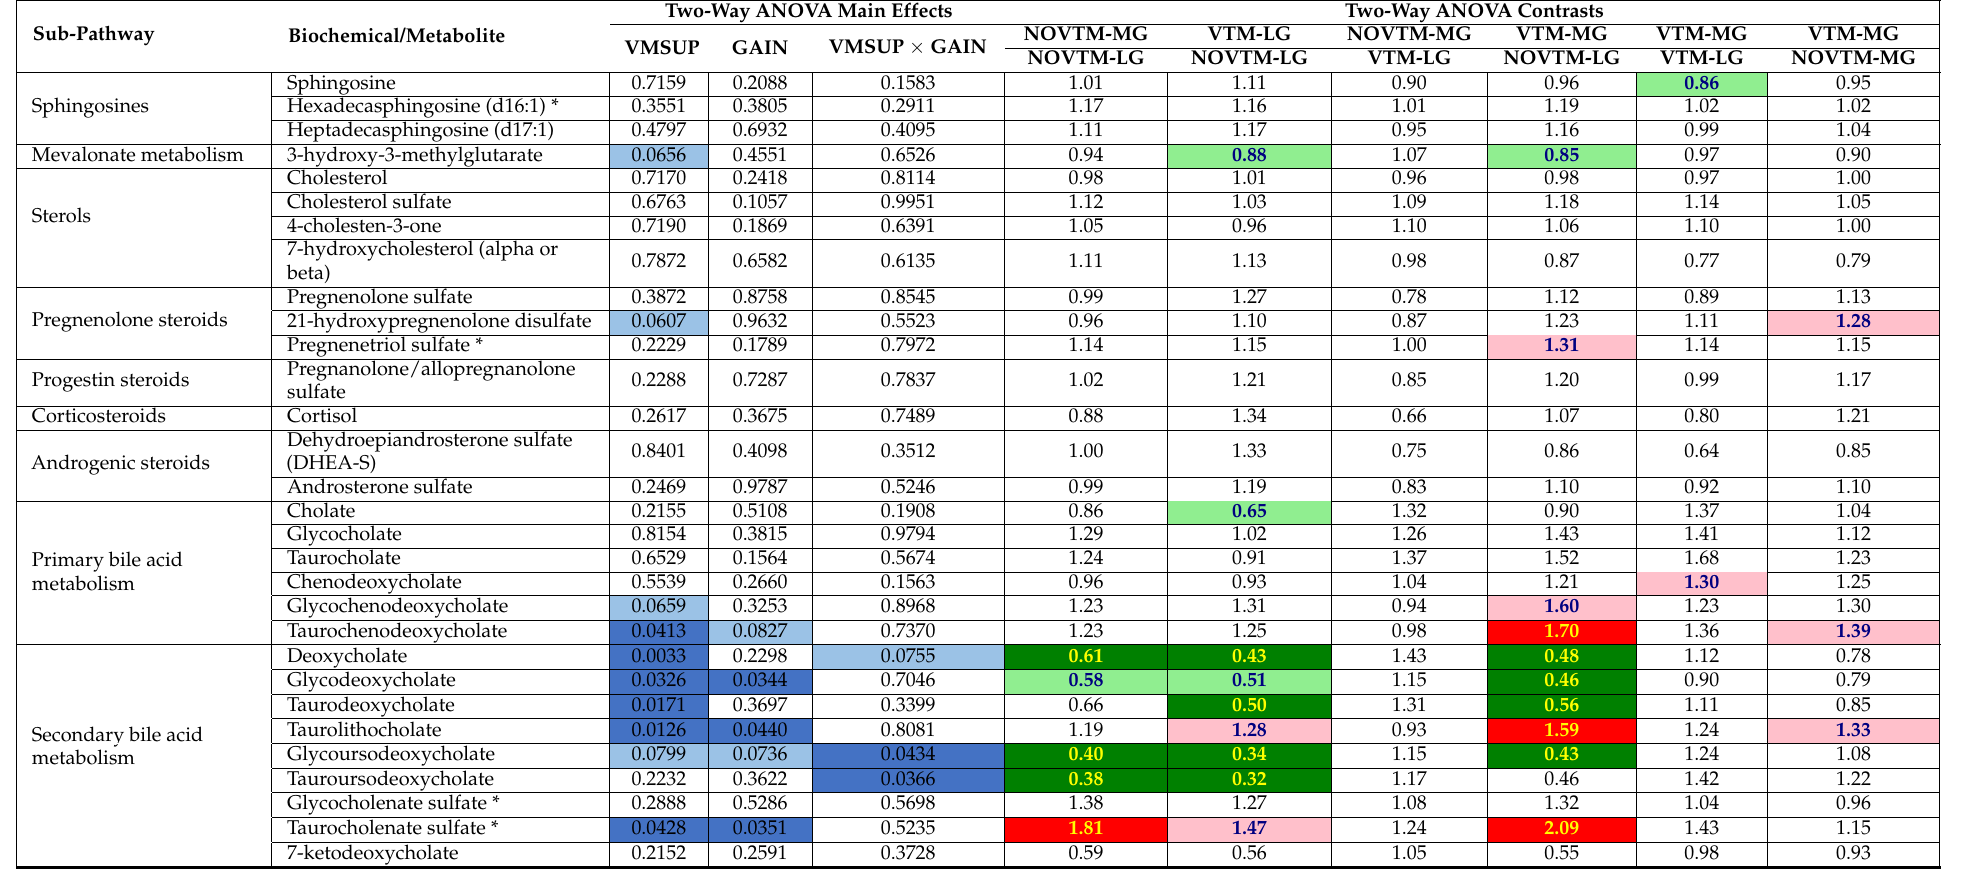
For the ANOVA, blue-shaded cells indicate p ≤ 0.05; light-blue-shaded cells indicate 0.05 < p < 0.10. Red- and green-shaded cells indicate p ≤ 0.05 (red indicates that the mean values are significantly greater for the comparison in question; green indicates significantly lower values). Light-red- and light-green-shaded cells indicate 0.05 < p < 0.10 (light red indicates that the mean values trend higher for the comparison in question; light green indicates that values trend lower). Biochemicals/metabolites denoted with * are compounds that have not been confirmed based on a standard but whose identity we are confident about—extracts are of sufficient purity to enable the necessary resolution for accurate